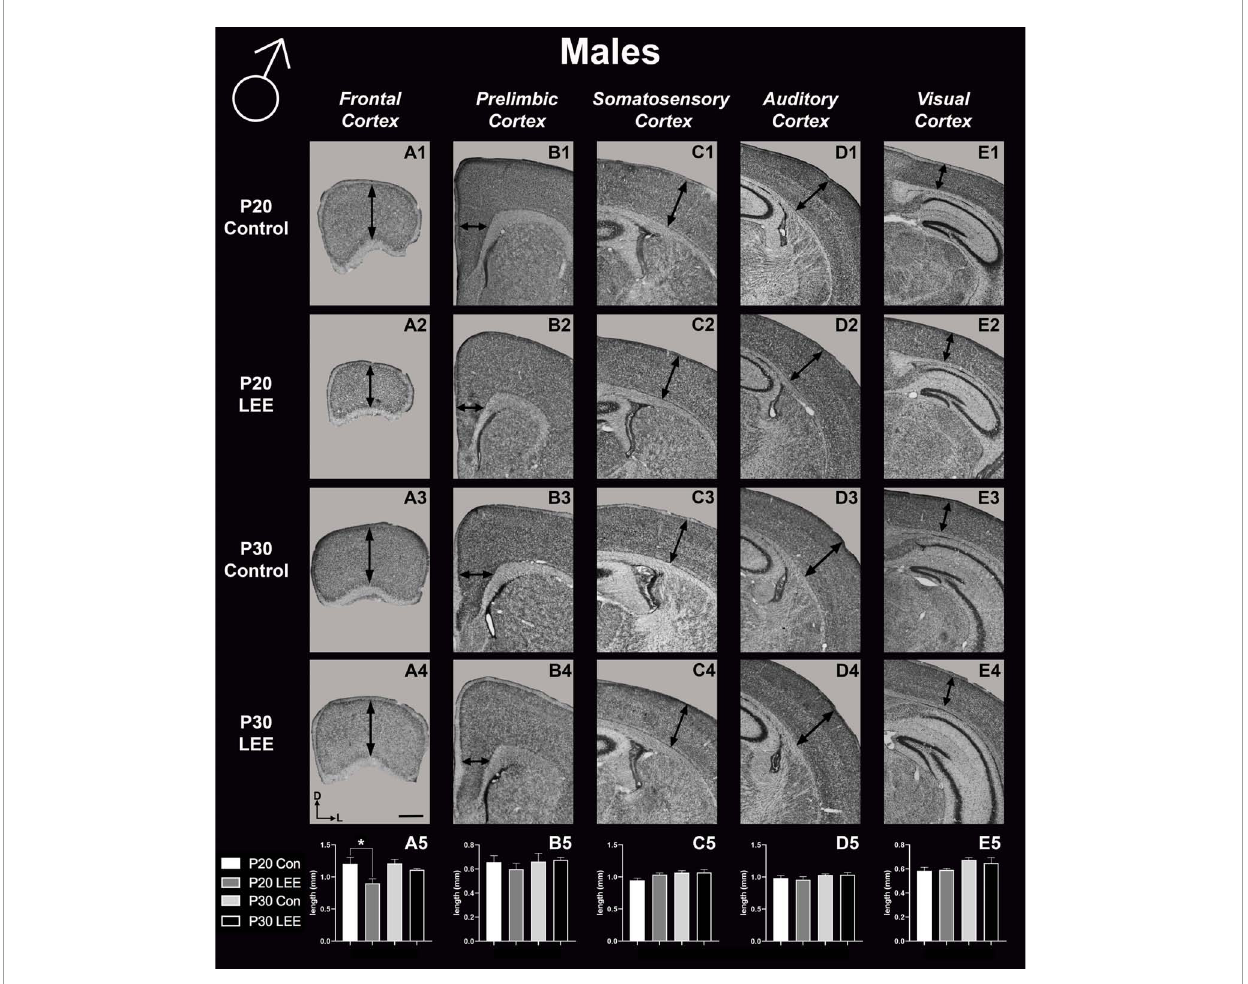
FIGURE6 Cortical thickness measurements – males. High magnification coronal sections of Nissl-stained hemisections. Measurements include frontal cortex ( A1–A5 ; N = 21), prelimbic cortex ( B1–B5 ; N = 16), somatosensory cortex ( C1–C5 ; N = 22), auditory cortex ( D1–D5 ; N = 19), and visual cortex ( E1–E5 ; N = 28). No significant differences between control and LEE males, except in the frontal cortex at P20 (A5, p = 0.0235). Data expressed as mean ± SEM. Images oriented dorsal (D) up and lateral (L) to the right. *Indicates p < 0.05. Scale bar, 1 mm.